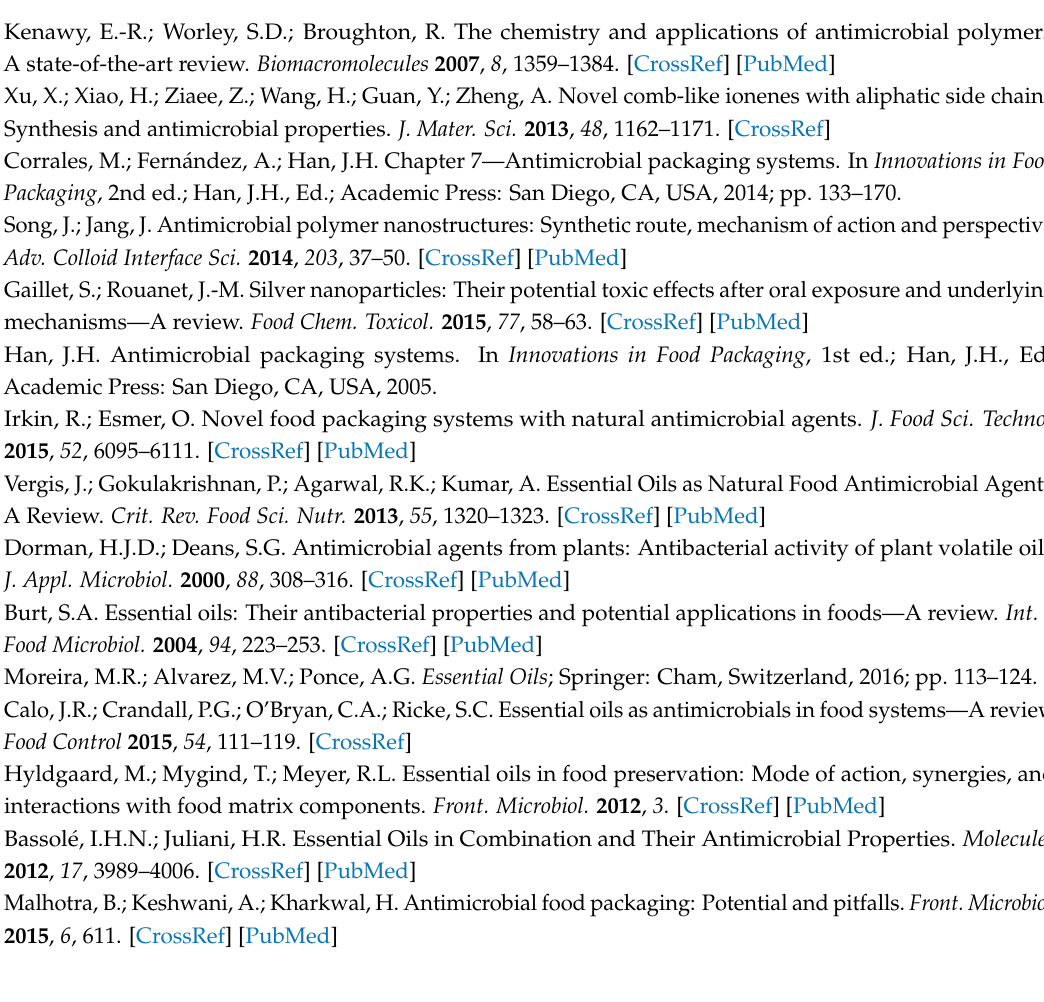
Figure S1: HR-SEM images of cryo-fractured cross-section of (a) PP/carvacrol and (b) PP/HNTs films. Several HNTs are marked with arrows for clarity, Figure S2: TGA thermograms of neat PP; PP/HNTs; PP/carvacrol; and PP/(HNTs-carvacrol) nanocomposite films over the entire temperature region studied, Figure S3: Full FTIR spectra (transmission mode) of pristine HNTs, carvacrol, neat PP, PP/HNTs, PP/carvacrol and PP/(HNTs-carvacrol)